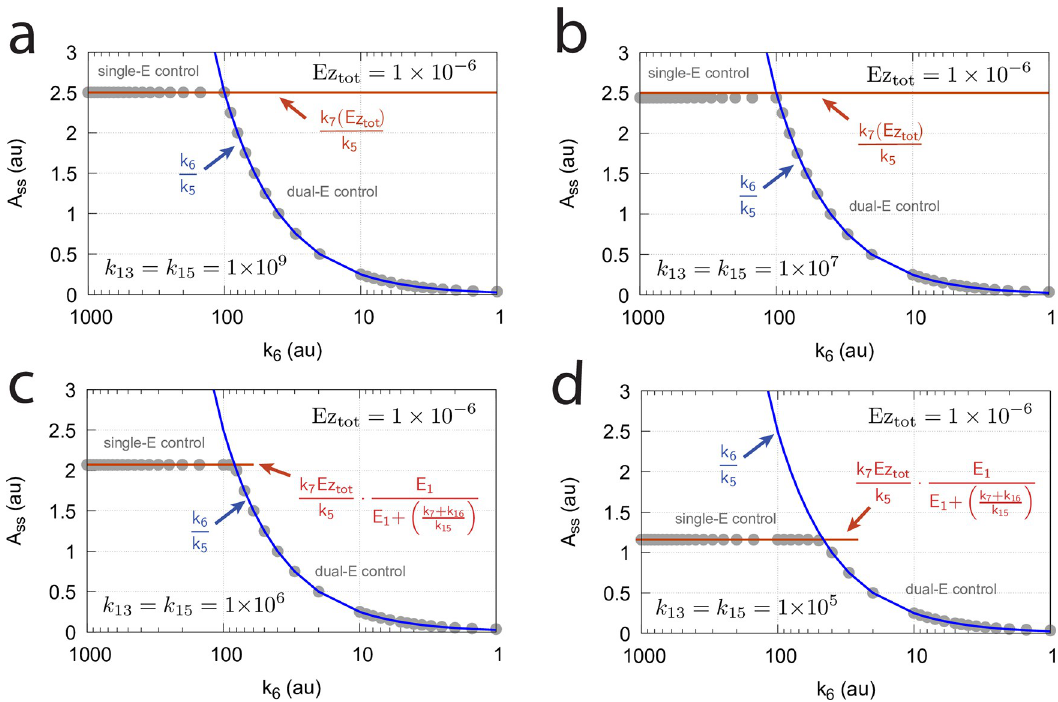
Fig 42. Switch between dual-E and single-E control in the m5 compulsory-order ternary-complex mechanisms ( E 2 binding first to Ez , Fig 40) as a function of k 6 , k 13 , and k 15 . The total enzyme concentration is 1 × 10 − 6 and constant. (a) k 13 = k 15 =1 × 10 9 . A set of / k 5 , analogous to Eq 99. (b) k 13 = k 15 =1 × 10 8 . Also in this case A of the single-E controller is the single-E controller is 2.5 (= k 7 � Ez tot set still close to 2.5. (c) k 9 = k 11 =1 × 10 6 . v ( _ P ) is no longer zero-order with respect to E 1 and E 2 , but is described by Eq 123, and A ss of the single-E controller is described by Eq 124 with E 1, ss =4.82 × 10 2 and A single (cid:0) E =2.07. (d) k 9 = k 11 =1 × 10 5 . At single-E control conditions ss =8.63 × 10 2 and A single (cid:0) E =1.16 (Eq 124). Other rate parameters as for Fig we have E 1, ss ss